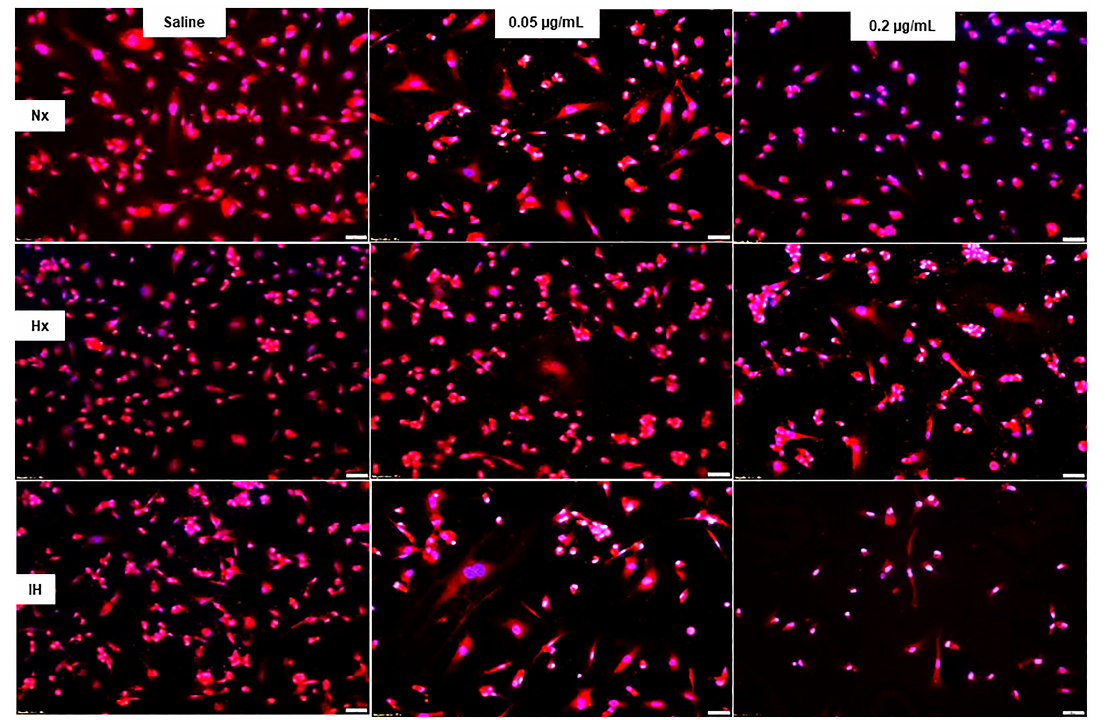
Figure 8. Representative images of the effect of bumetanide on aquaporin (AQP)-1 immunoreactivity (red) counterstained with DAPI (blue) in cultured human microvascular retinal endothelial cells (HMRECs) exposed to normoxia (Nx), hyperoxia (Hx, 50% O 2 ), or intermittent hypoxia (IH) for 72 h. Images were captured at 20× magnification (scale bar is 50 µm). Quantitative analysis of AQP-1 immunoreactivity is presented in Table 1.